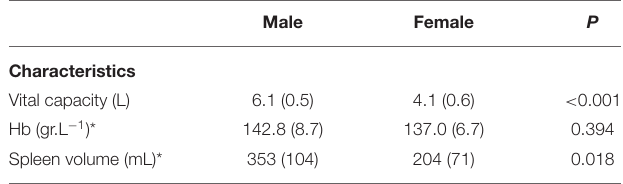
TABLE 1 | Baseline characteristics divided by